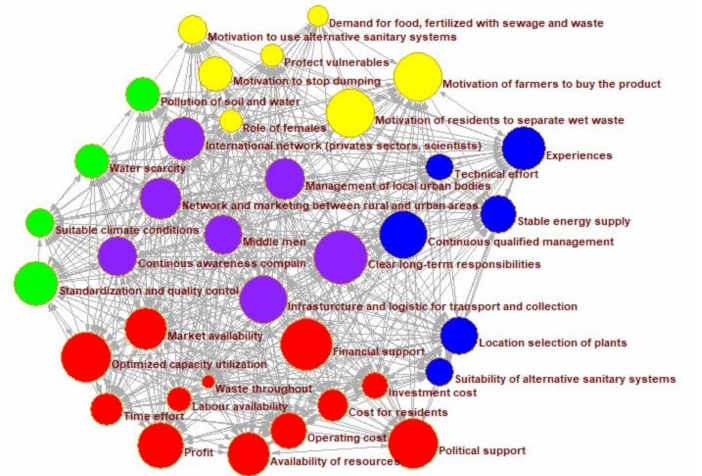
Figure 3. Social network analysis of indicators of co-recycling concepts between rural and urban areas from the view of thematic stakeholders. This is generated by using the cognitive mapping method (described in the material and method section). The indicators are represented by colored circles and the relation by lines. The larger the circle the higher its centrality and relevance for the concept. The color code is: green = ecological, yellow = social, blue = technical, red = economical, purple =